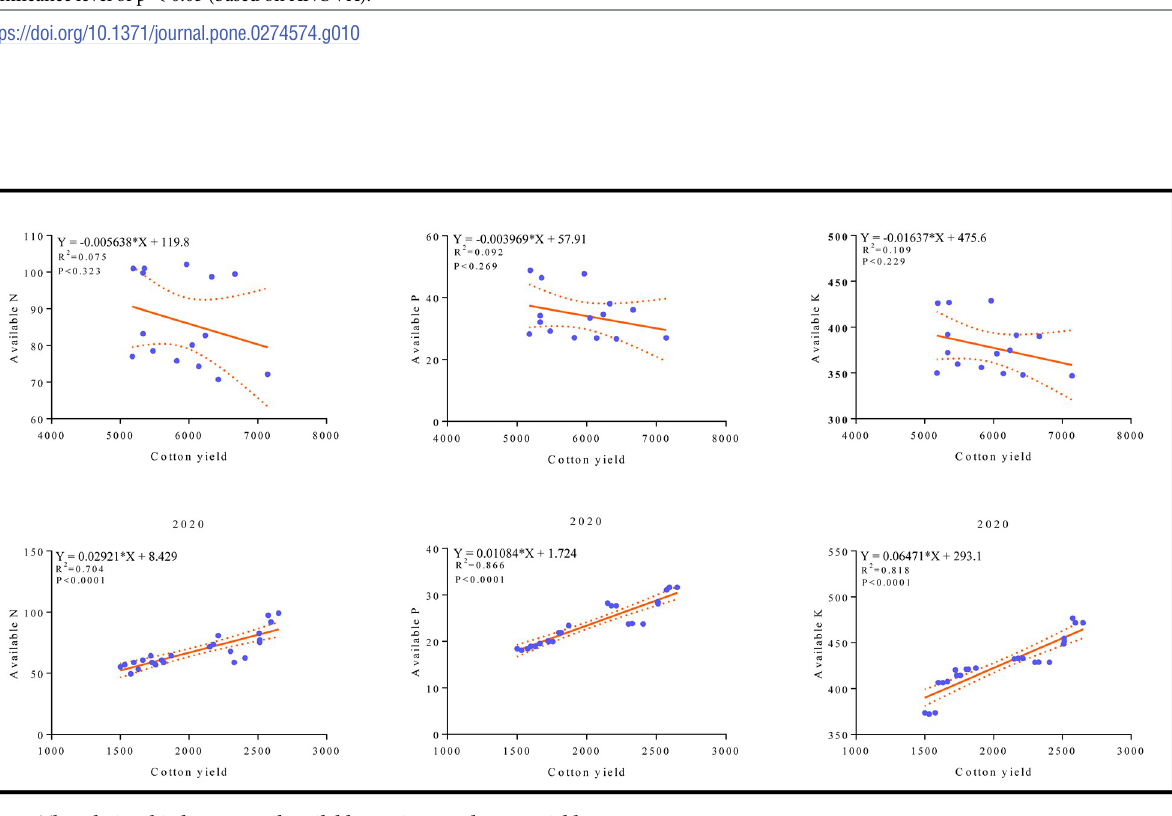
PLOS ONE | https://doi.org/10.1371/journal.pone.0274574 October 14,